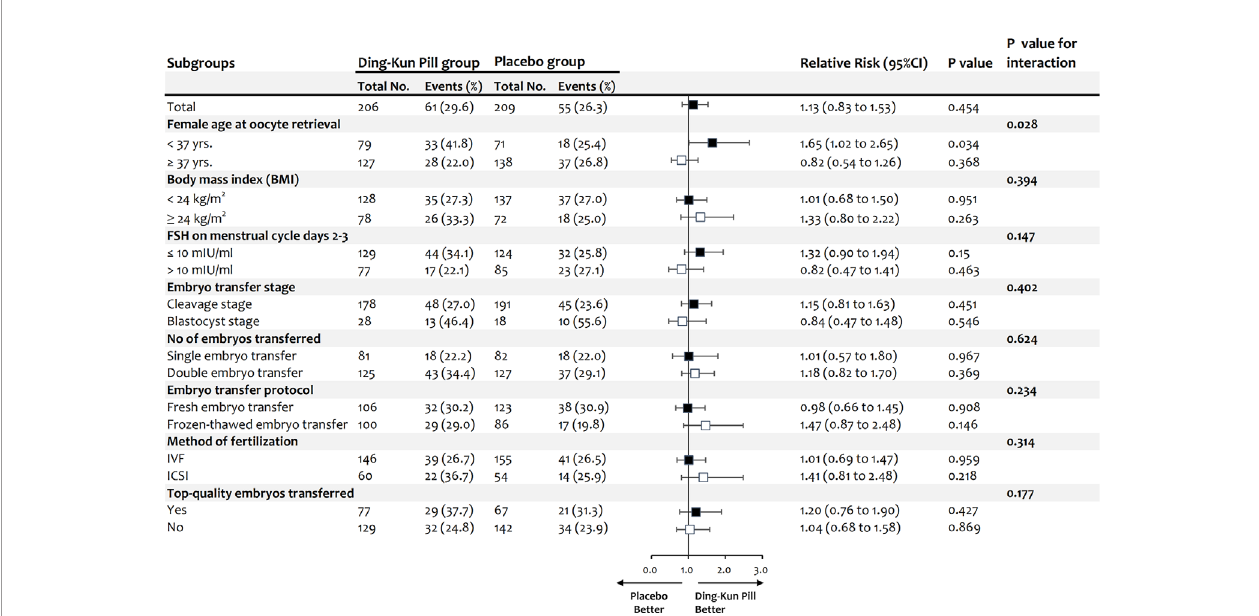
FIGURE 1 | Subgroup analysis of ongoing pregnancy rate per embryo transfer for women in Ding-Kun Pill and placebo groups. (FSH, follicle stimulating hormone; IVF, in vitro fertilization; ICSI, intracytoplasmic sperm